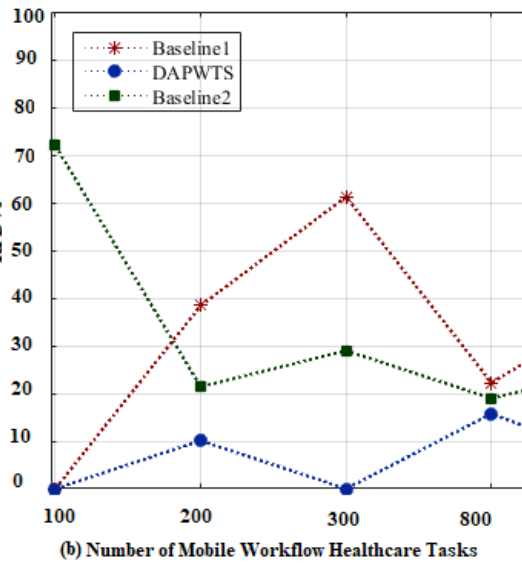
Figure 8. Workflow application no. of tasks completed within a given